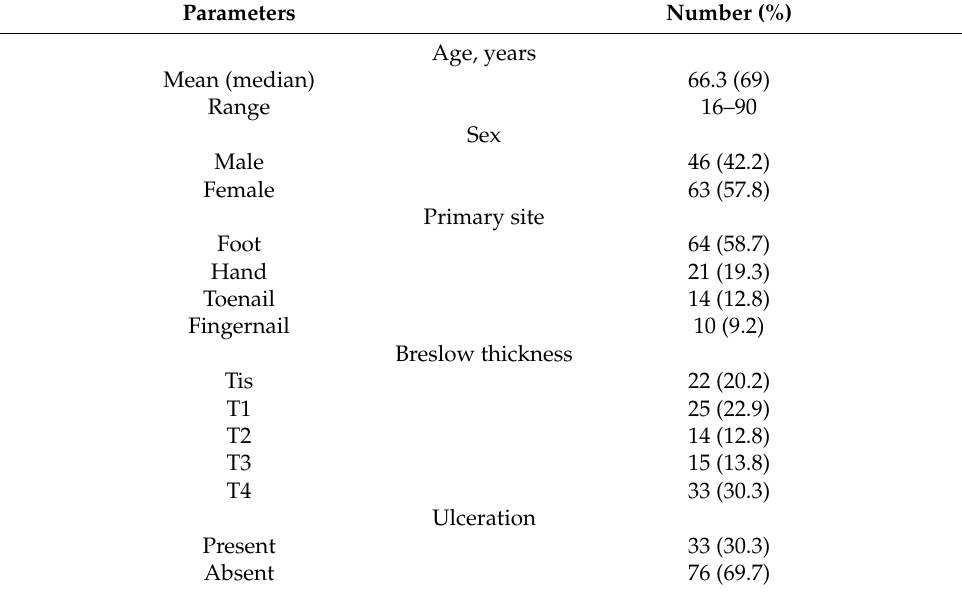
Table 1. Background data of all 109